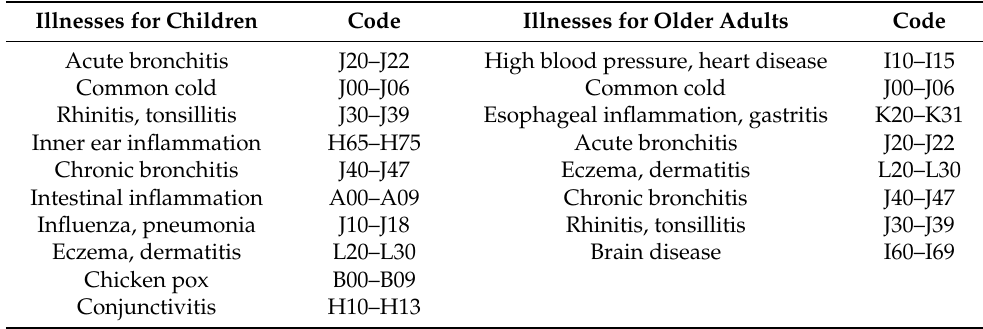
Table 1. Illnesses in children and older adults selected for